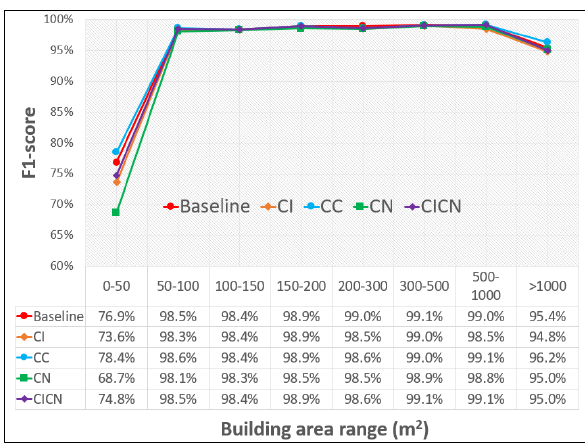
Figure 10 . F1-score of different building area